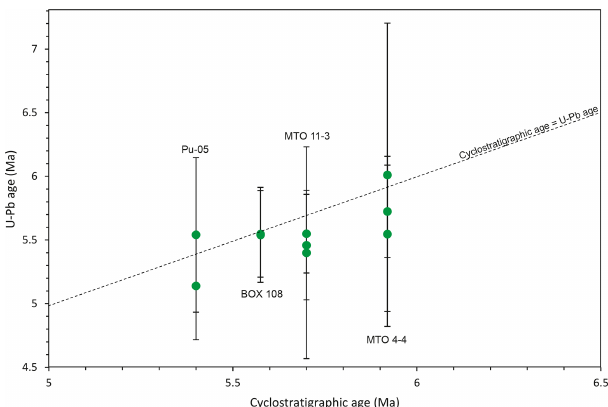
Figure 5. Comparison of the obtained U–Pb ages and the expected cyclostratigraphic ages. The weighted mean of the offsets between the two ages is − 0 . 14 ± 0 . 14Ma ( ± 2 σ ). The dashed line represents the U–Pb age with the cyclostratigraphic age